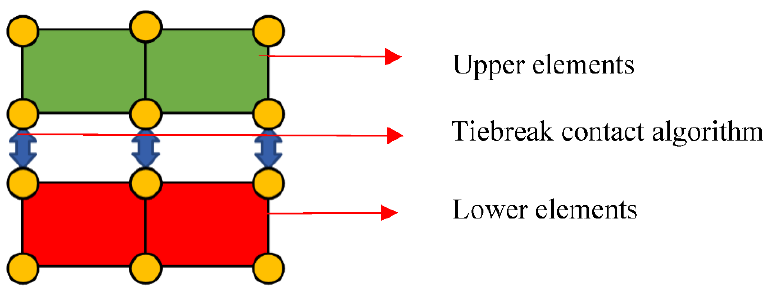
Figure 1. The tiebreak contact algorithm schematic diagram.